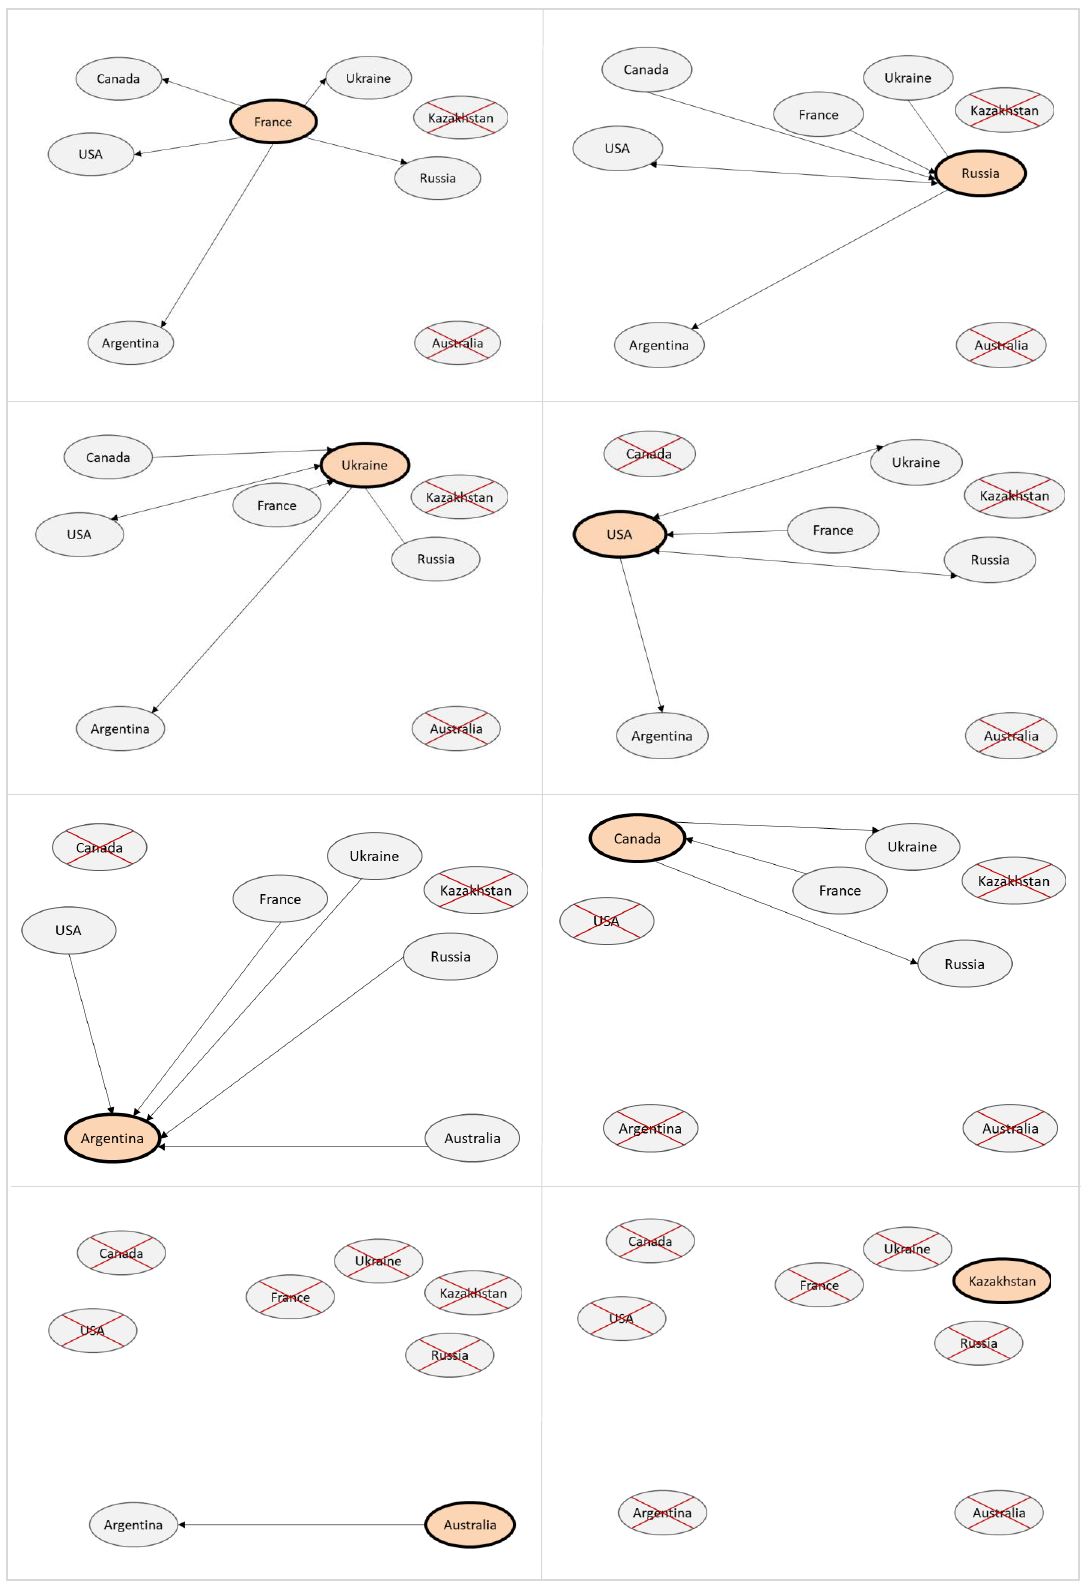
Figure 5. Schematic view of the cointegration channels (based on the results of the test of linear cointegration). Note: The arrows indicate the direction of price transmission based on the results of the weak exogeneity test. For example, the arrow for the Australia–Argentina market pair indicates that wheat prices in Australia transmit price shocks to the Argentinian wheat